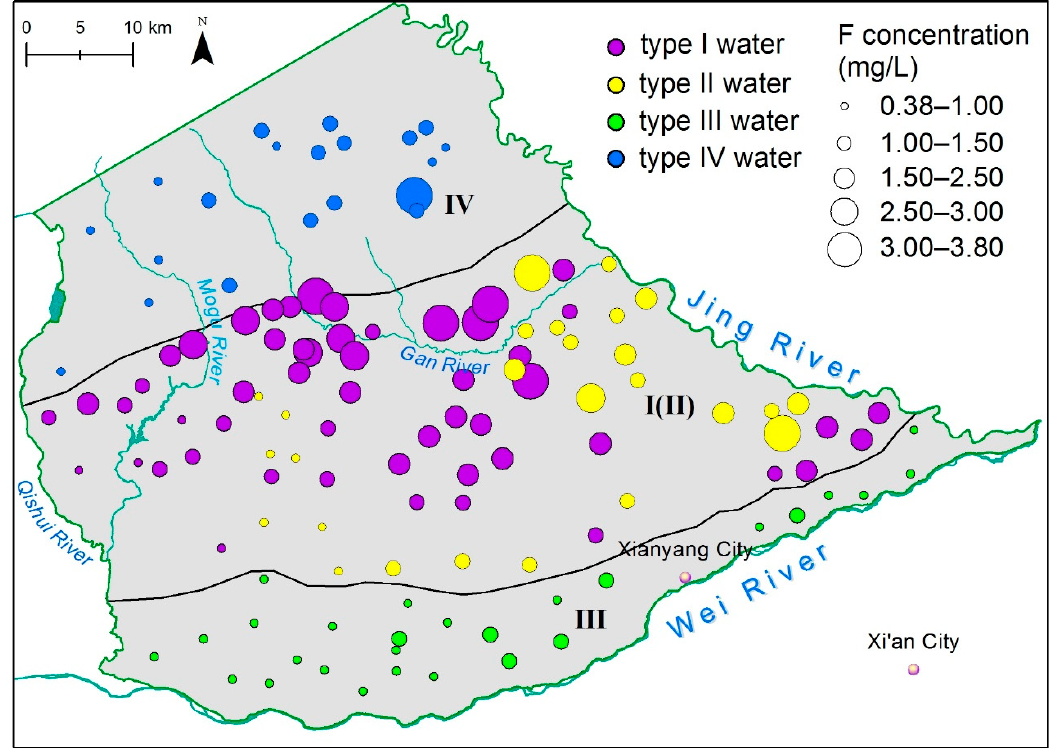
Figure 4. The distribution of fluoride concentration from all groundwater samples.